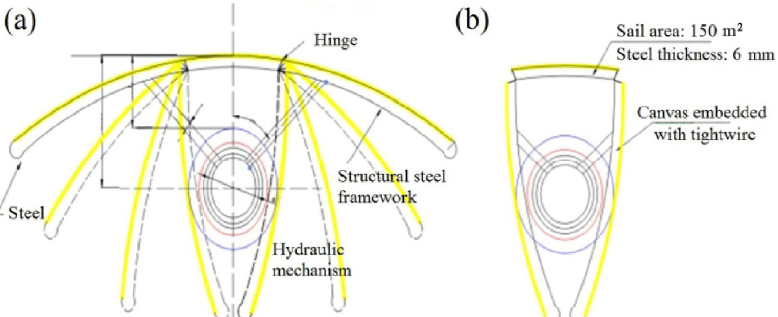
Fig. 5 Foldable rigid sail: (a) furling condition; (b) stretch